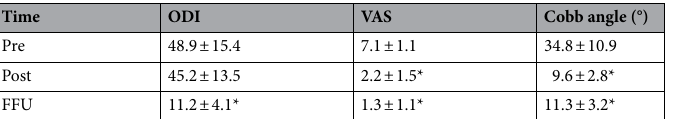
Table 3. Changes of ODI and VAS and Cobb angle before and after the operation. *, compare with preoperation P < 0.05. ODI Oswestry Dability Index, VAS Visual Analogue Scale, Pre preoperative, Post Postoperative, FFU final follow-up.